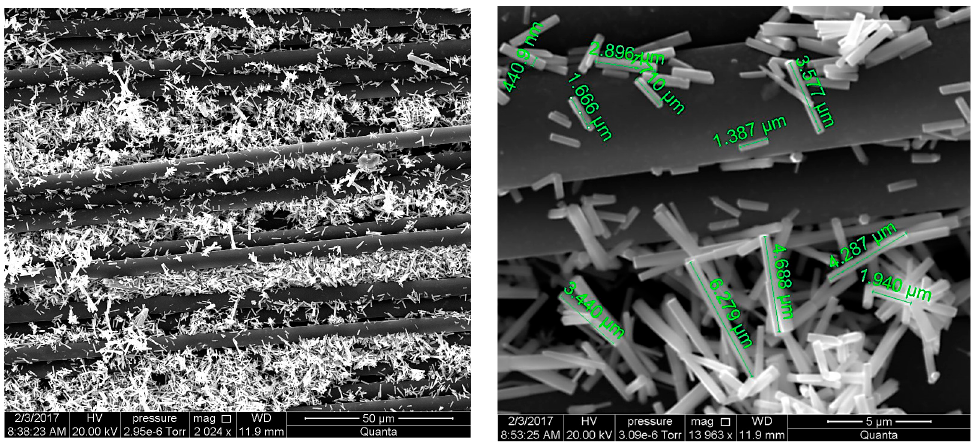
Figure 1. ZnO nanorods grown on carbon fiber substrate at different magnifications.